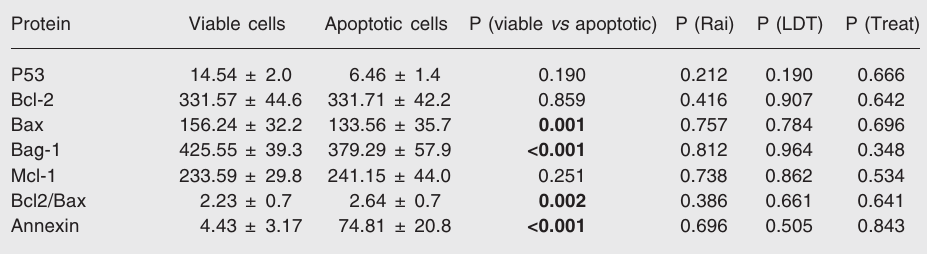
Table 3. Comparison of protein expression (MFI) between viable and apoptotic cells before fludarabine incubation.